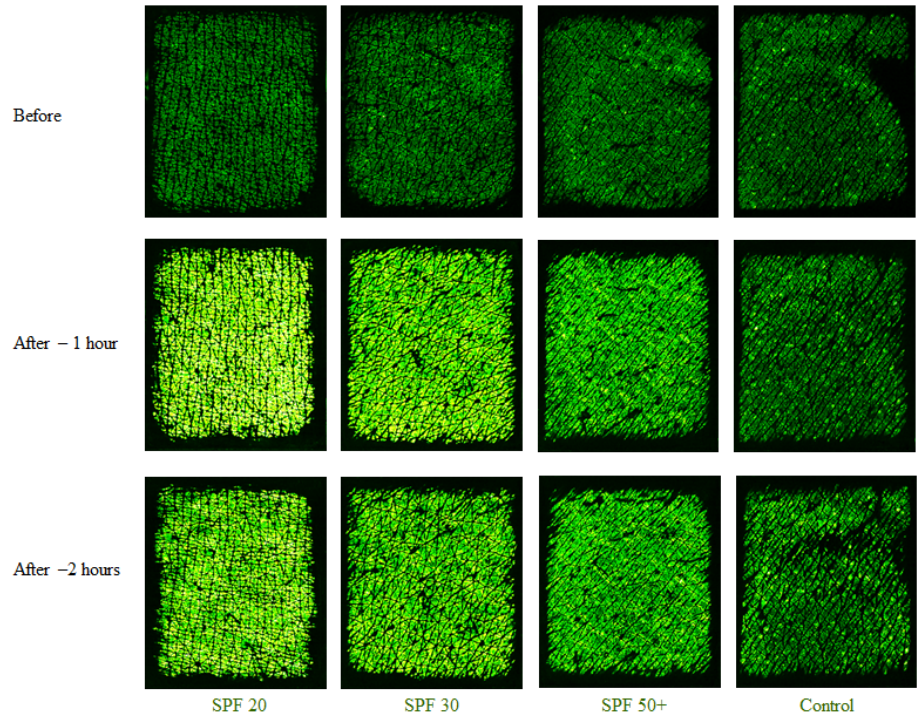
Figure 5. Epsilon permittivity images of four volar forearm test sites before, 1 h after, and 2 h after application of sunscreen. SPF 20, SPF 30, and SPF 50+ sunscreen was applied on three skin sites. The fourth skin site was used as a control.